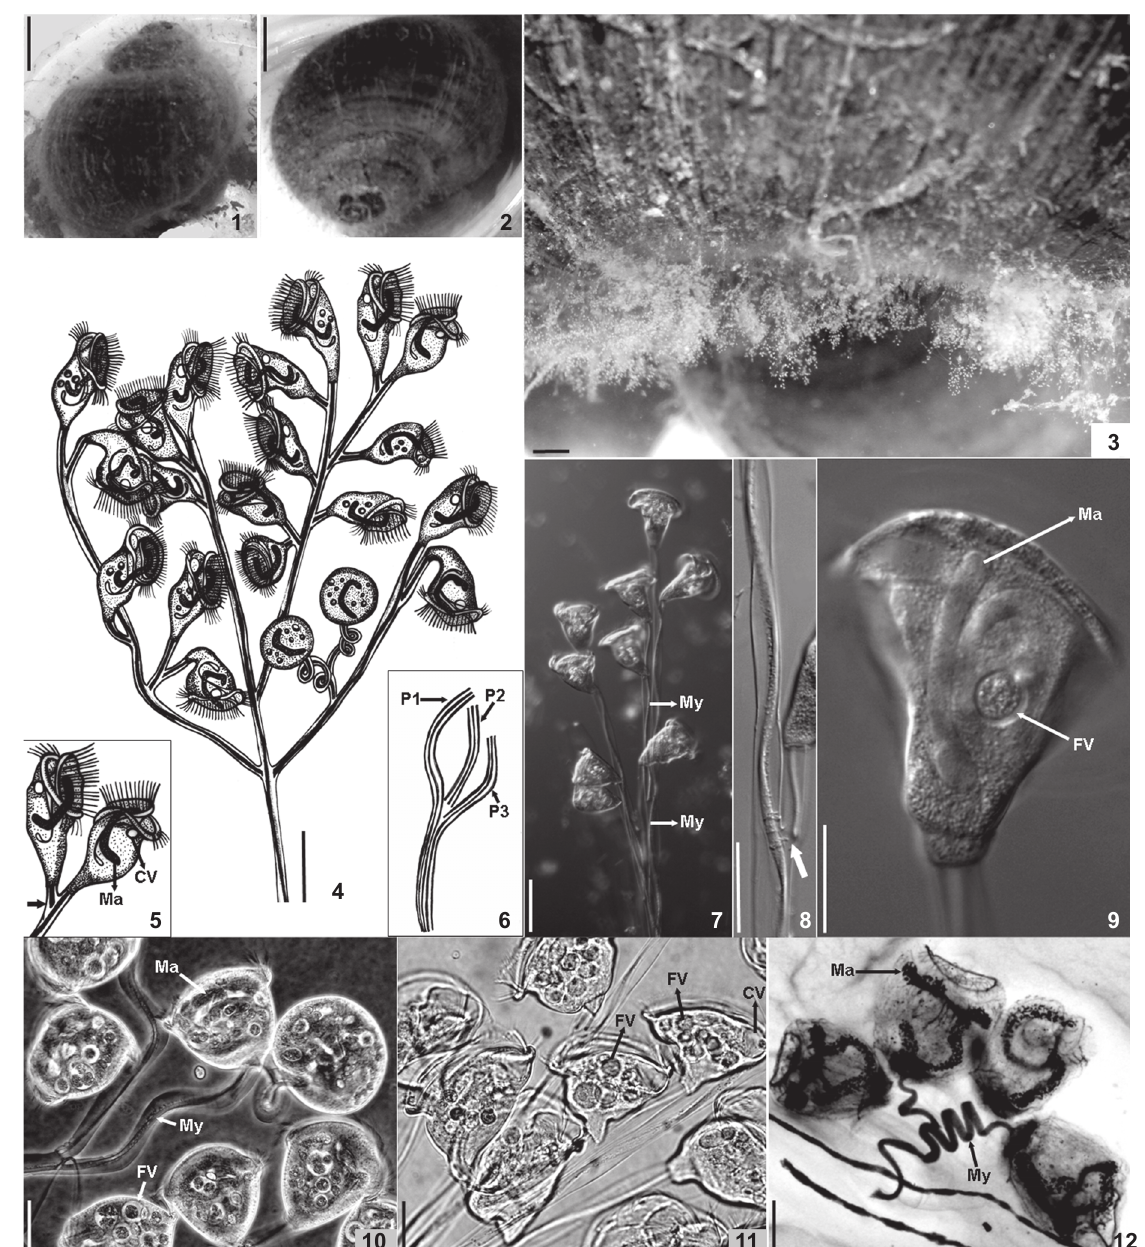
Figures 1-12. Photomicrographic images of C. polypinum attached to the freshwater apple snail P. figulina . (1-3) Colonies of C. polypinum attached to P. figulina (high infestation). (4) Schematic drawing of the colony of C. polypinum . (5) Schematic drawing of two zooids showing macronuleus (Ma), contractile vacuoles (CV) and the non-continuous myonemes of the colony (arrow). (6) A diagrammatic drawing of the buccal morphology based on protargol silver preparations, showing oral polykinetids 1 (P1), oral polykinetids 2 (P2), and oral polykineitids 3 (P3). (7) Colony ( in vivo ) showing myonemes (My), differential interference contrast microscopy. (8) Detail of the non-continuous myonemes (arrow), differential interference contrast microscopy. (9) Zooid ( in vivo ) showing macronuleus (Ma) and food vacuoles (FV), differential interference contrast microscopy. (10-11) Colony ( in vivo ) showing macronuleus (Ma), myonemes (My), food vacuoles (FV) and contractile vacuoles (CV), phase contrast and bright field microscopy, respectively. (12) Protargol impregnation showing macronuleus (Ma) and myonemes (My). Bars: (1-2) 1 cm, (3) 1 mm, (4 and 7) 100 µm, (8-12) 50